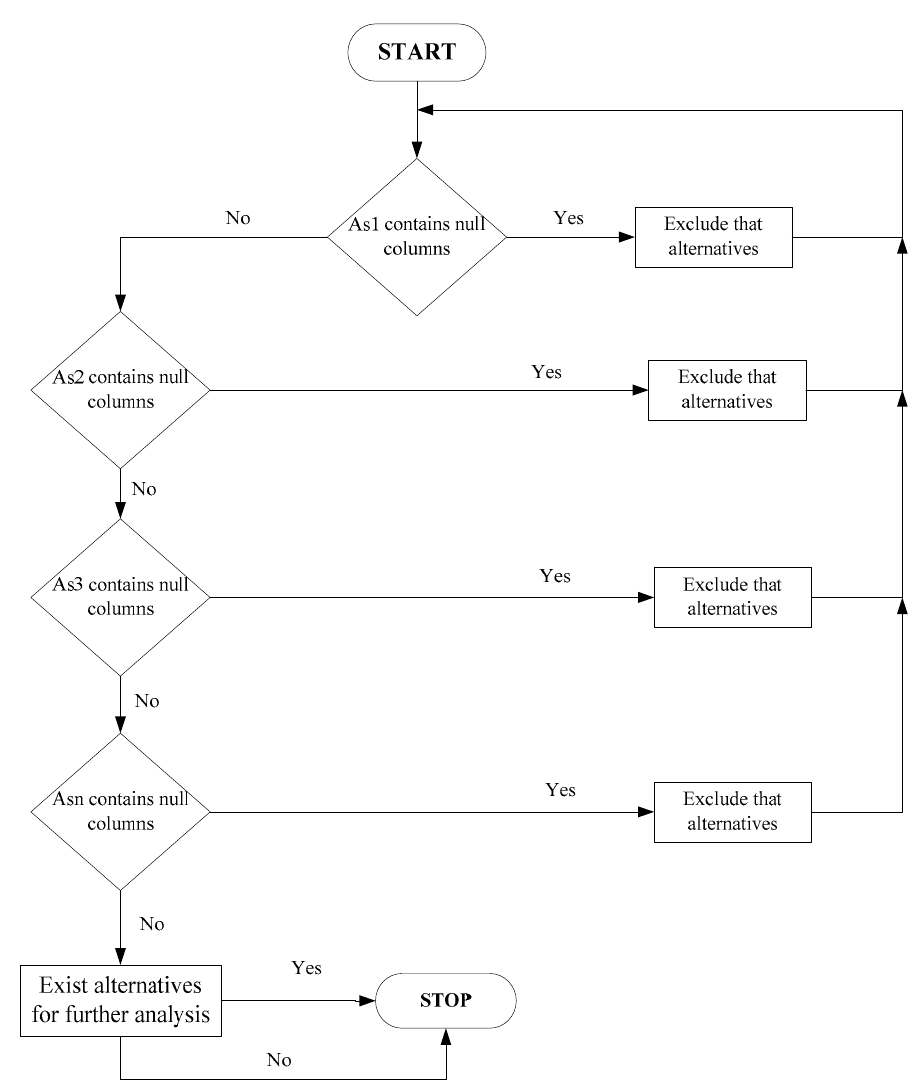
Figure 3. Flowchart of the proposed method with binary elimination matrix.